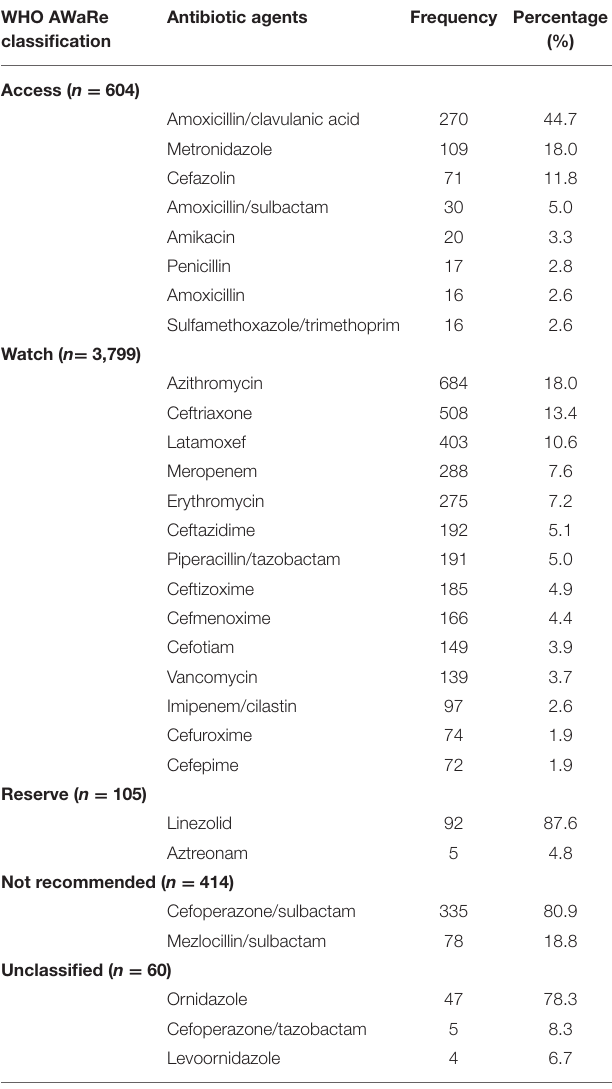
TABLE 4 | 4982 antibiotics prescriptions pattern for Chinese children based on WHO AWaRe classification by drug utilization 90% in 2017–2019. WHO AWaRe